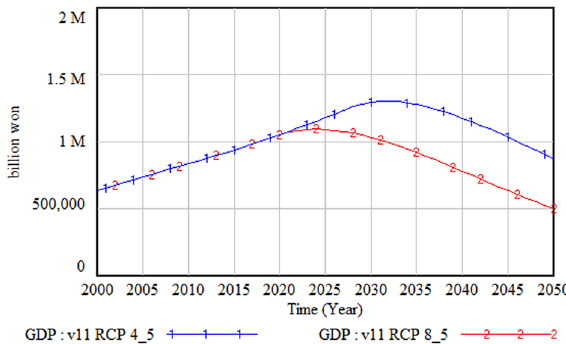
Figure 18. Gross domestic product (GDP) change under RCP 8.5 vs RCP 4.5.